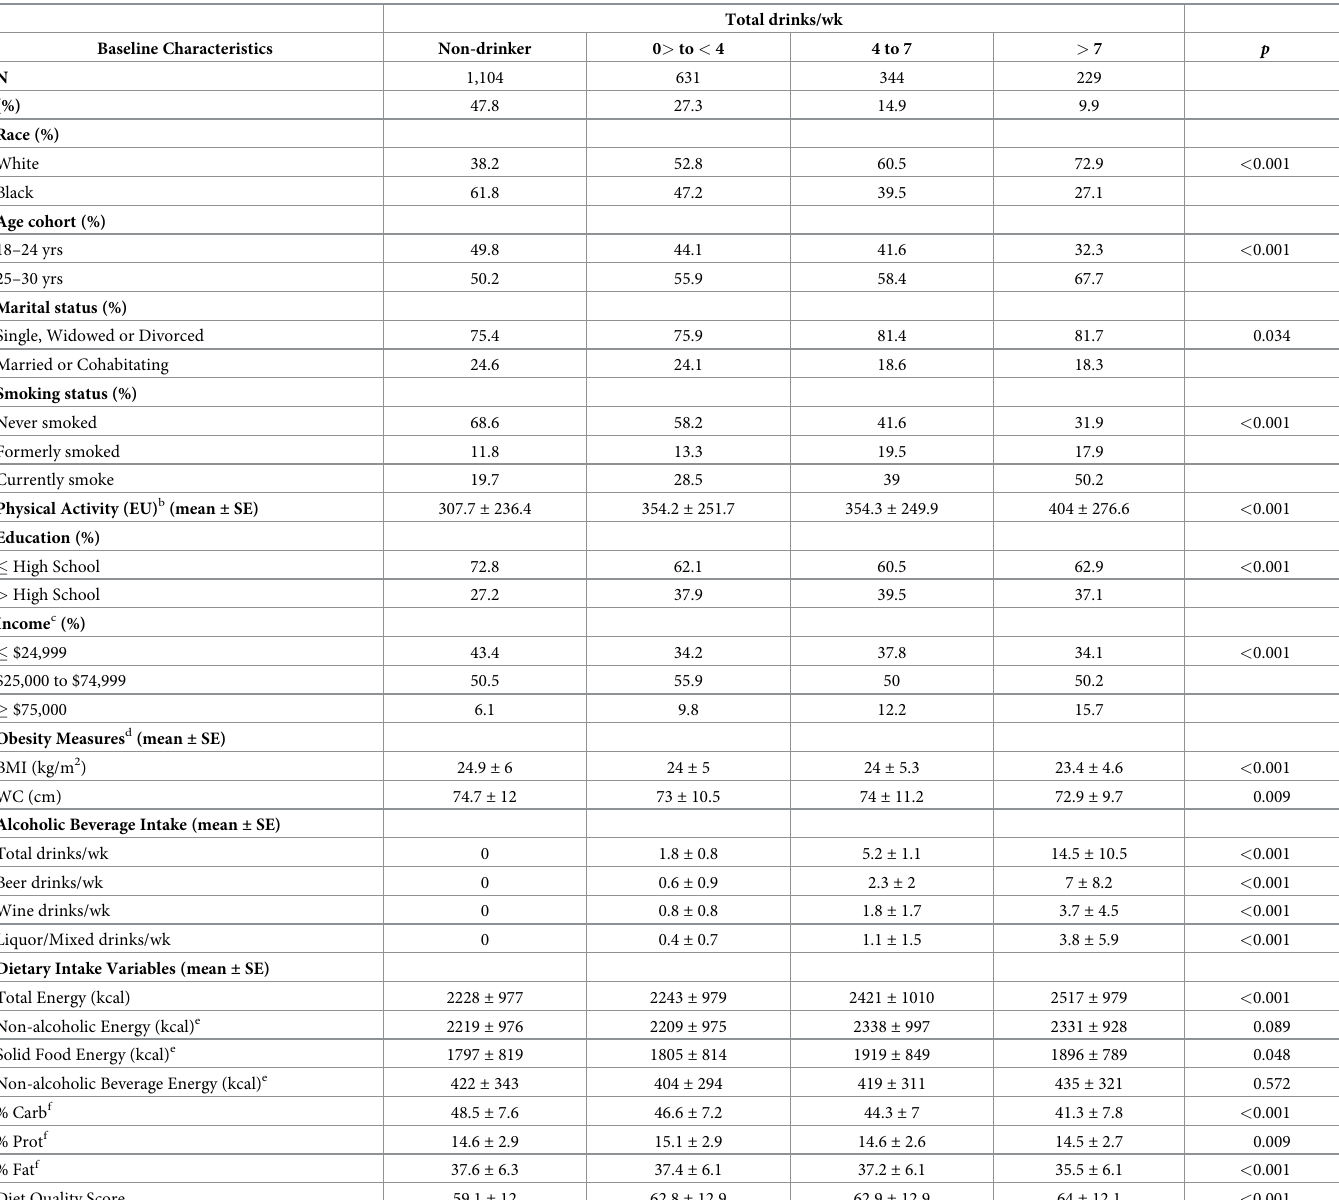
Table 2. Baseline characteristics of women in the CARDIA study 1985–1986, according to baseline alcoholic beverage intake (total drinks/wk) a .